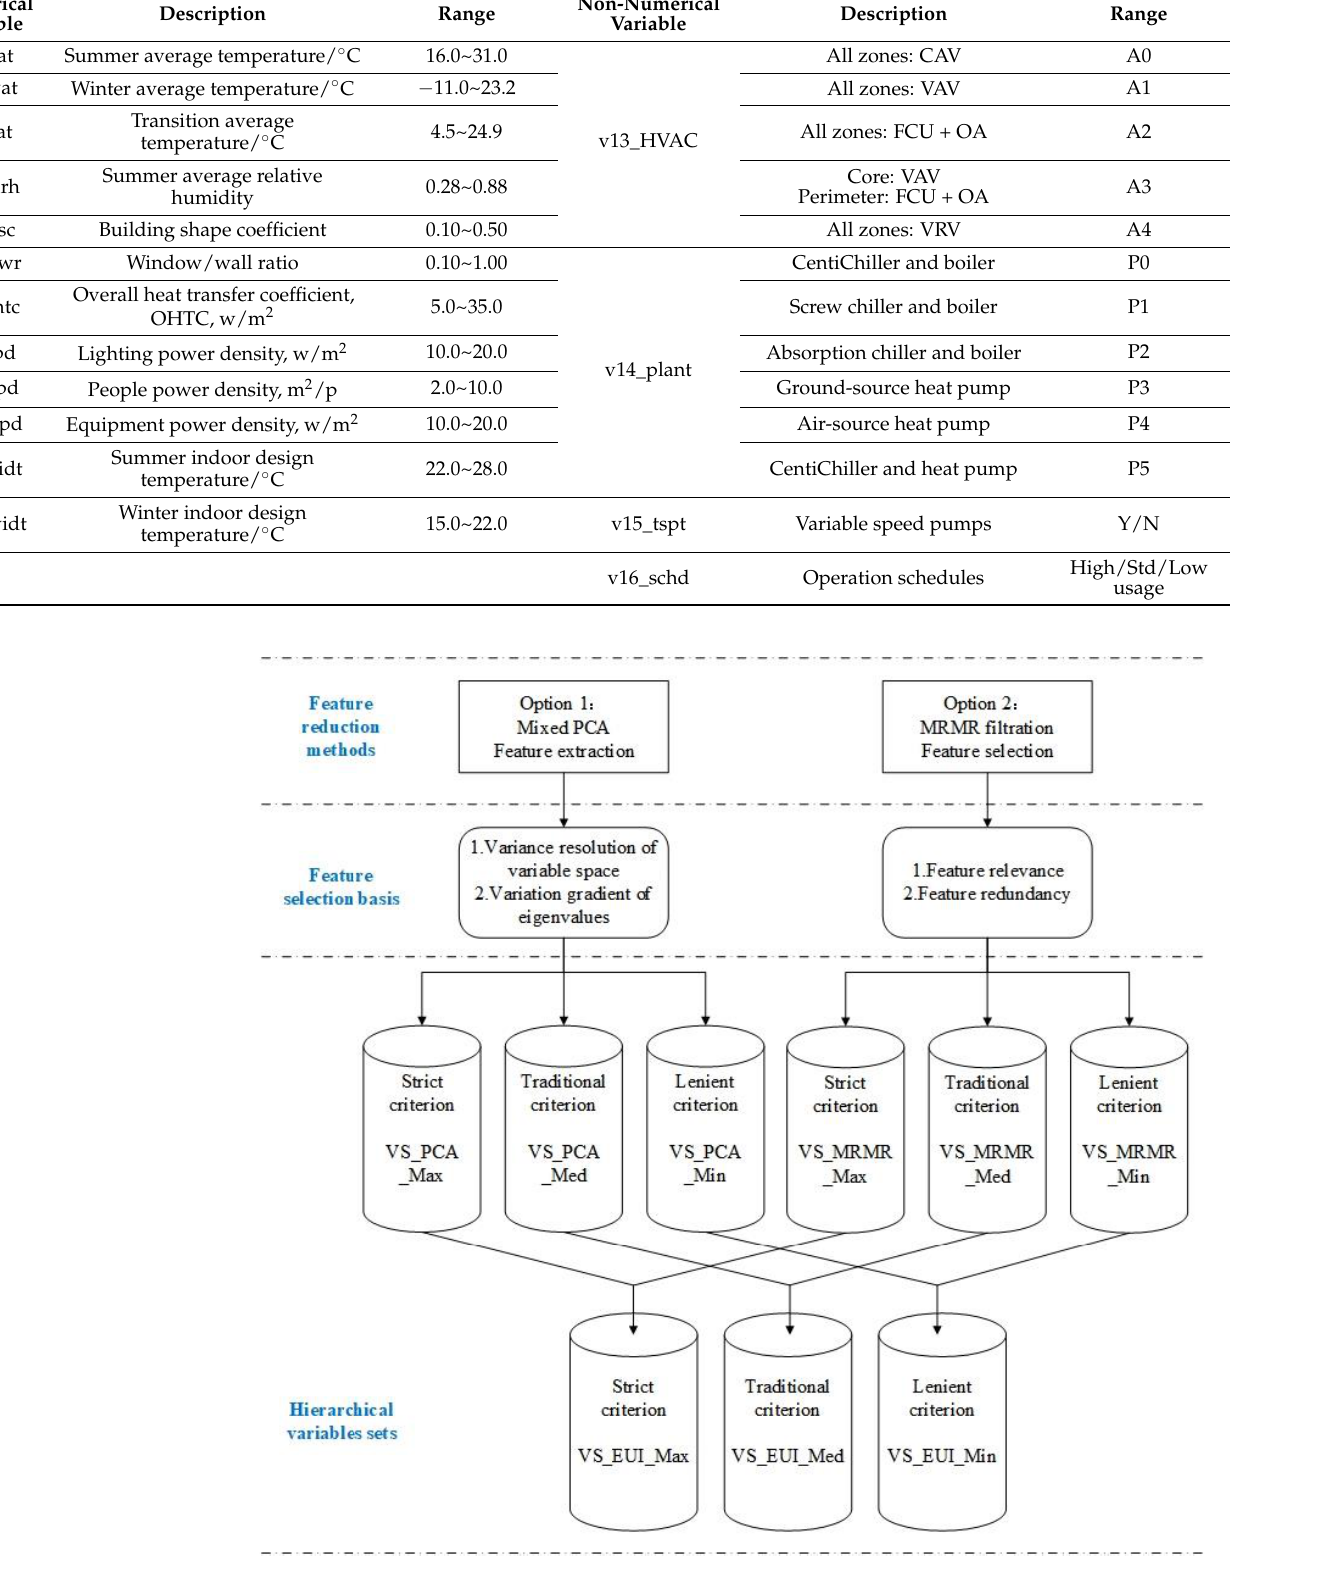
Figure 2. The construction method of minimum variable sets (MVSs).